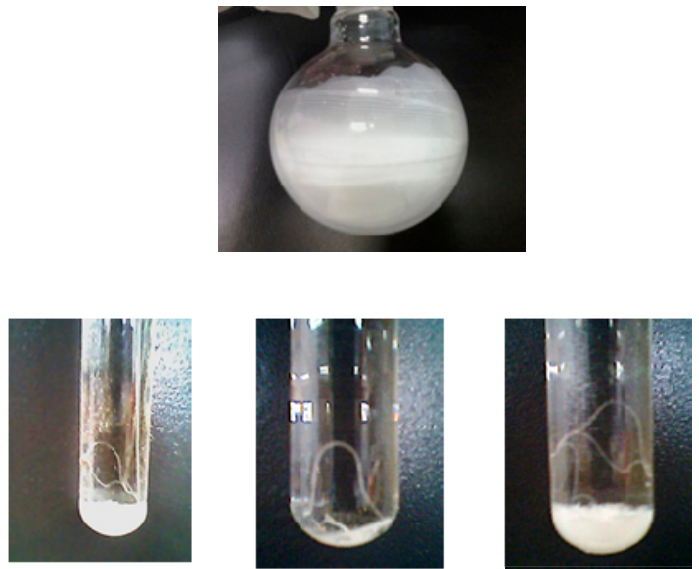
Figure 8. Picture of strands-shaped aggregates of derivative 8a observed in hexane/ethyl acetate system (up) and in ethyl acetate solution (down).